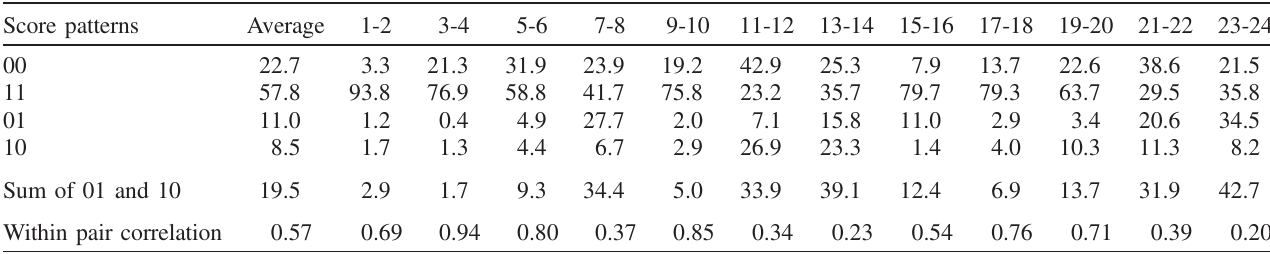
TABLE IV. LCTSR paired score patterns (in percentage) of U.S. college freshmen students ( N ¼ 1576 ). For the mean values listed in the table, the maximum standard error is 1.12%. Therefore, a difference larger than 3% can be considered statistically significant ( p < 0 . 05 ). The distribution of responses patterns for each question pair is significantly different from random guessing ( p < 0 . 001 ). For example, the results of chi square tests for question pairs 13-14 and 21-22 are χ ð 3 Þ ¼ 240 . 097 , p < 0 . 001 and χ ð 3 Þ ¼ 55 . 838 , p < 0 . 001 ,